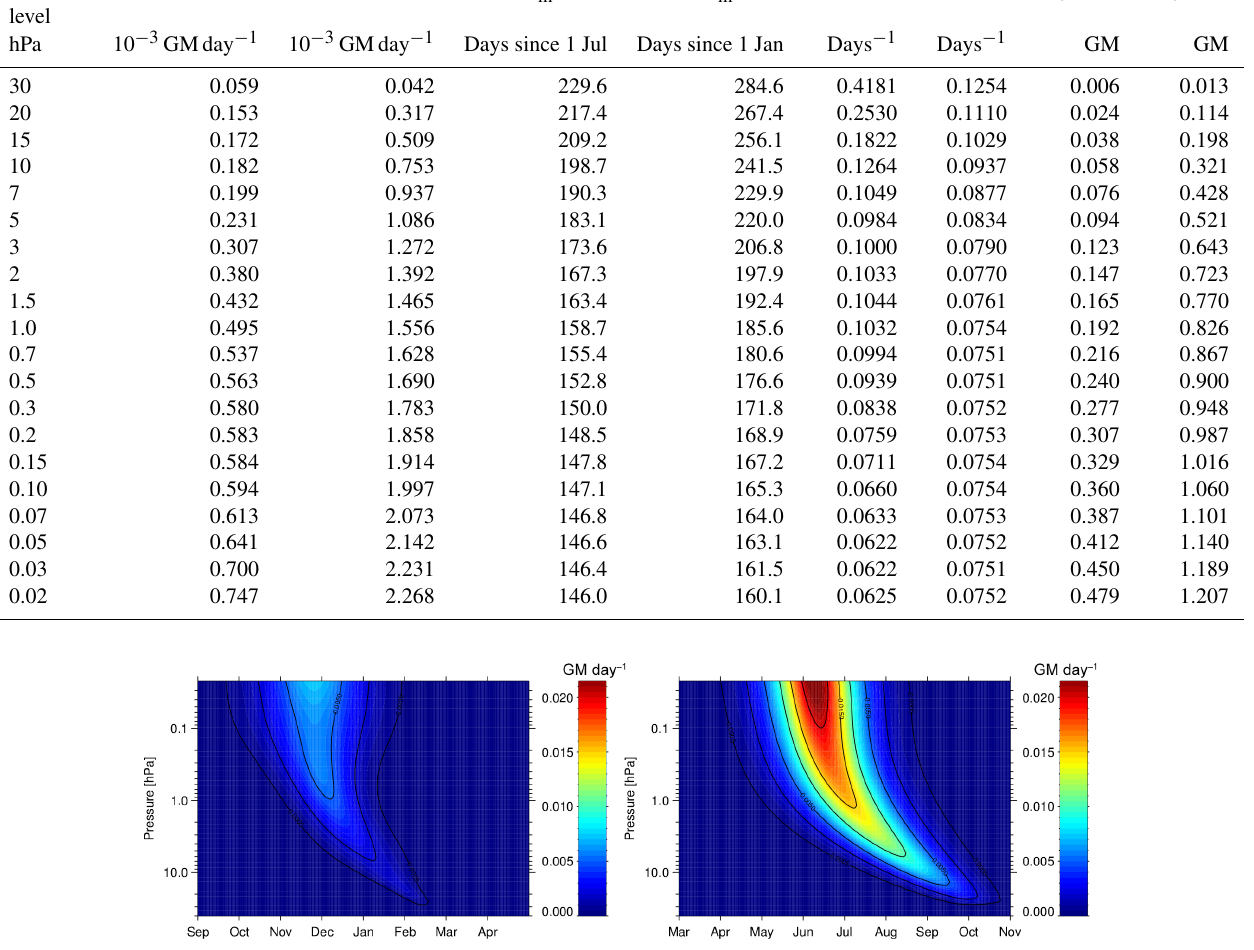
Figure 4. Temporal evolution of EPP-NO y fluxes F EEP (z) through the vertical level z indicated by the y axis during September–May in the NH (left) and March–November in the SH (right) as a result of the empirical model for the 2002–2012 average A p index of